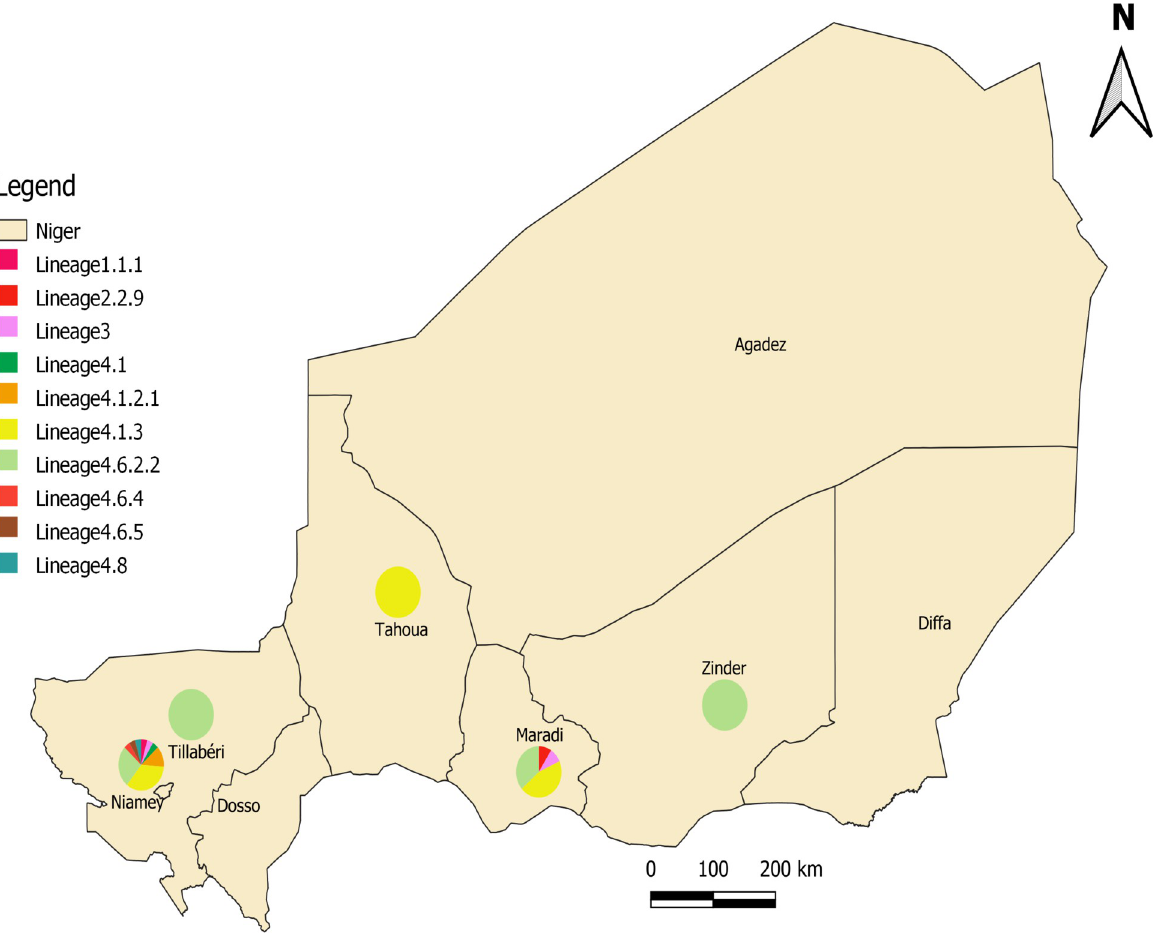
Fig 1. Geographical distribution of M . tuberculosis lineages/sub-lineages in Niger. Map created with DIVA-GIS (https://www.diva-gis.org/ gdata) using GADM version 1.0 data (https://gadm.org/data.html).